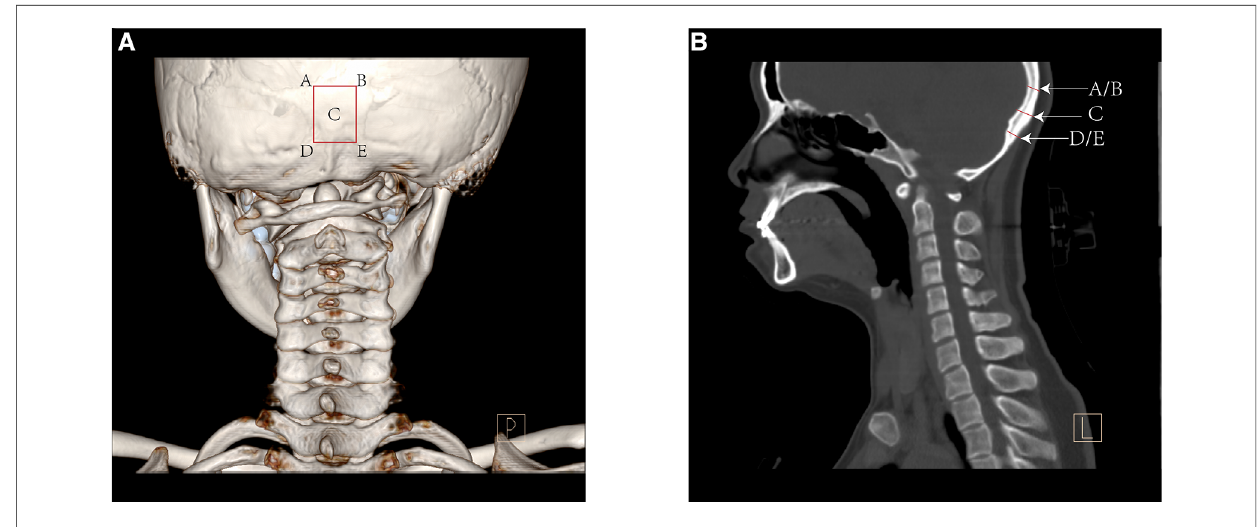
FIGURE 1 The posterior view of computed tomography (CT) 3D reconstruction ( A ) and the sagittal reconstruction ( B ) showed the method to measure the bone thickness of the occipital